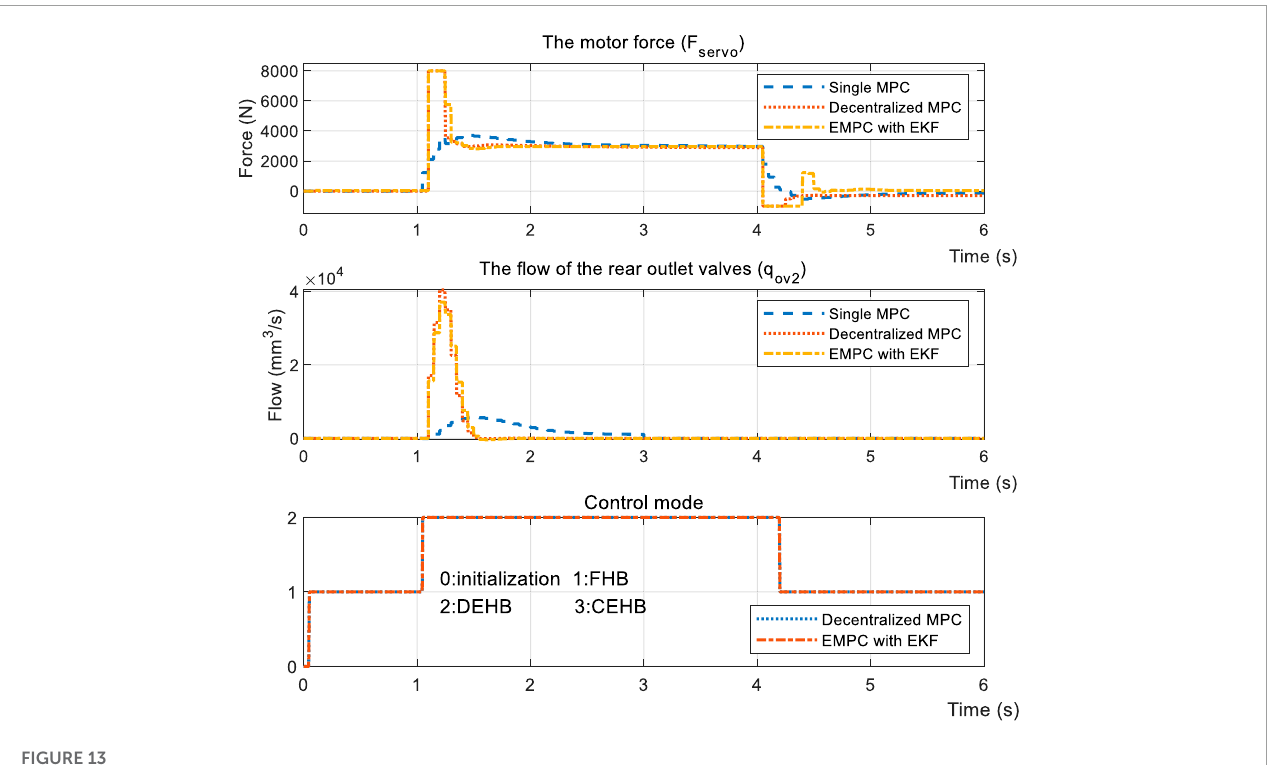
FIGURE 13 Input signal of step response under the DEHB condition.